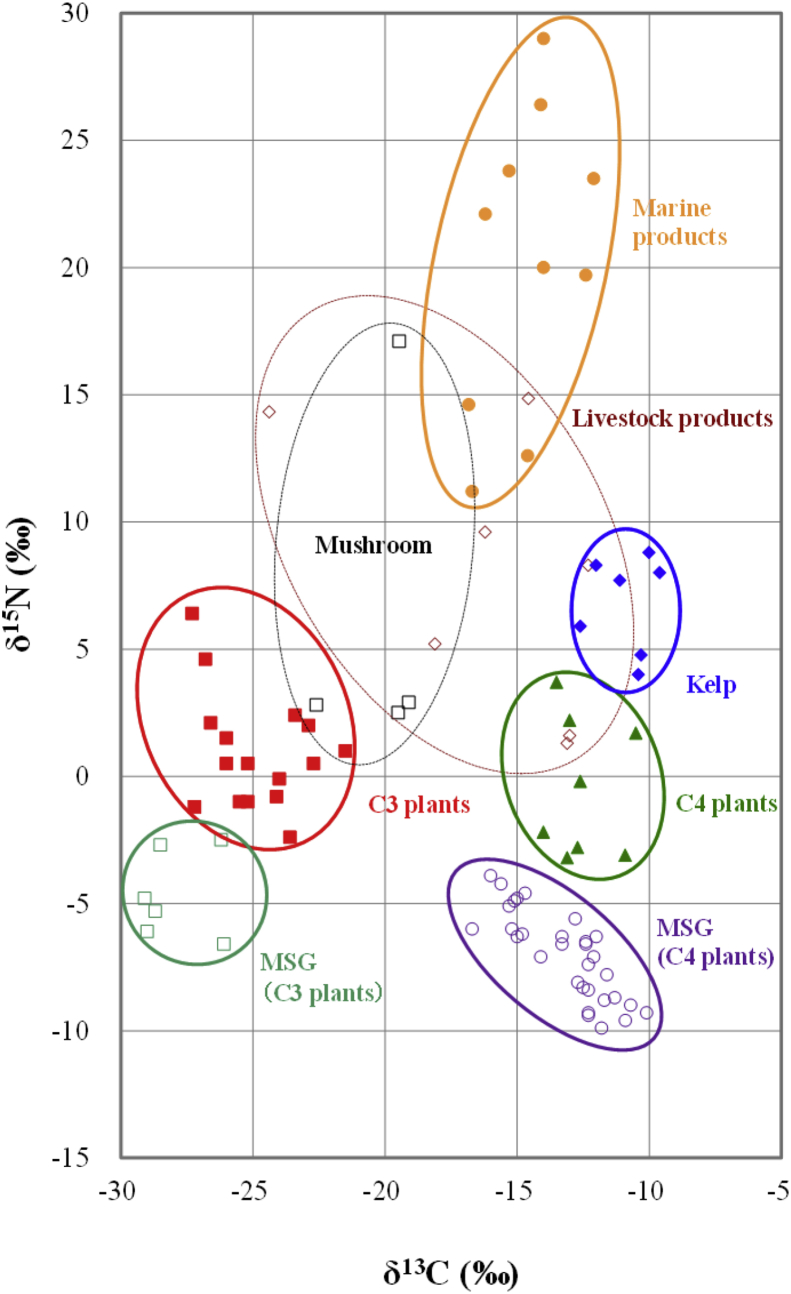
δ13C and δ15N value from glutamic acid in foodstuffs and seasoning MSG.